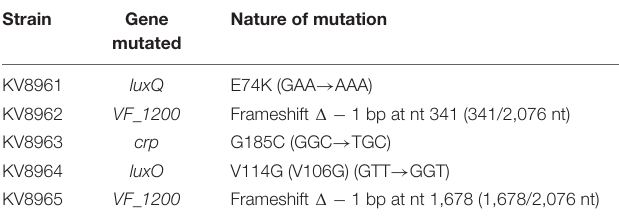
TABLE 4 | Identity of KB2B1 motility suppressor mutants.